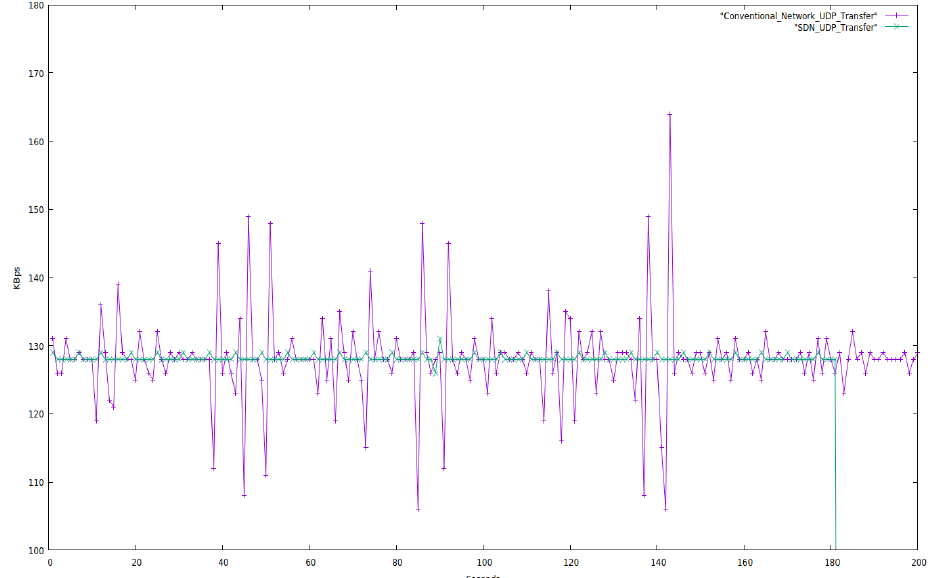
Figure 9. Transfer Rate/Throughput of SDN vs. Traditional Network.